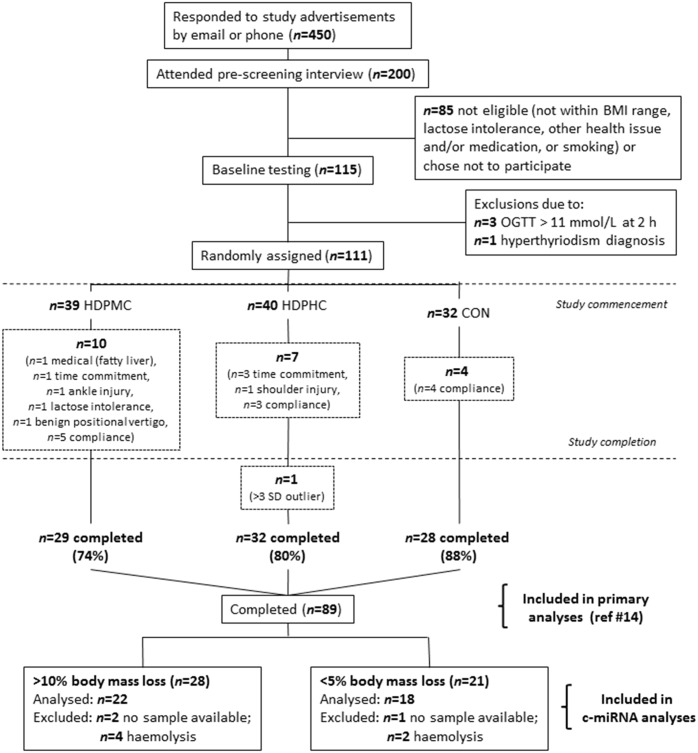
Flowchart of participants throughout the 16 wk diet and exercise intervention and in the subsequent analysis of high (HiRes) and low (LoRes) responders to the intervention.HDPHC, high dairy protein moderate fat; HDPMC, high dairy protein moderate fat; CON, control. Compliance was to the diet and/or the exercise training.